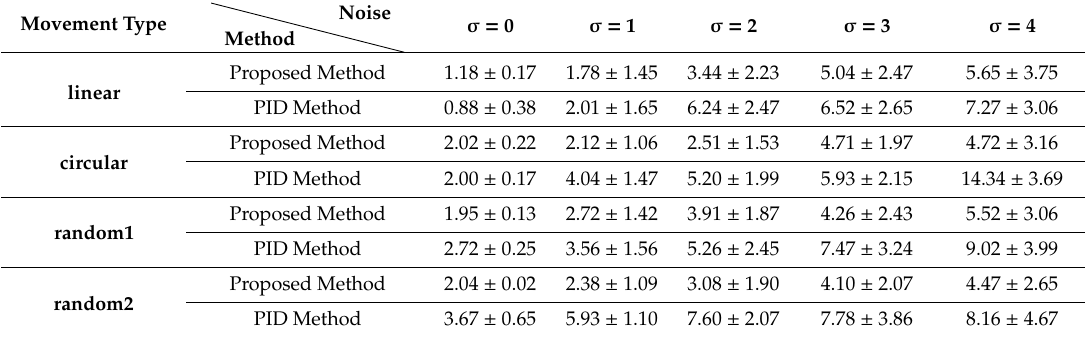
Table A3. Tracking results of UAV in the sensor noise environment. The root-mean-square error in the y -axis direction and data confidence interval are shown in this table.